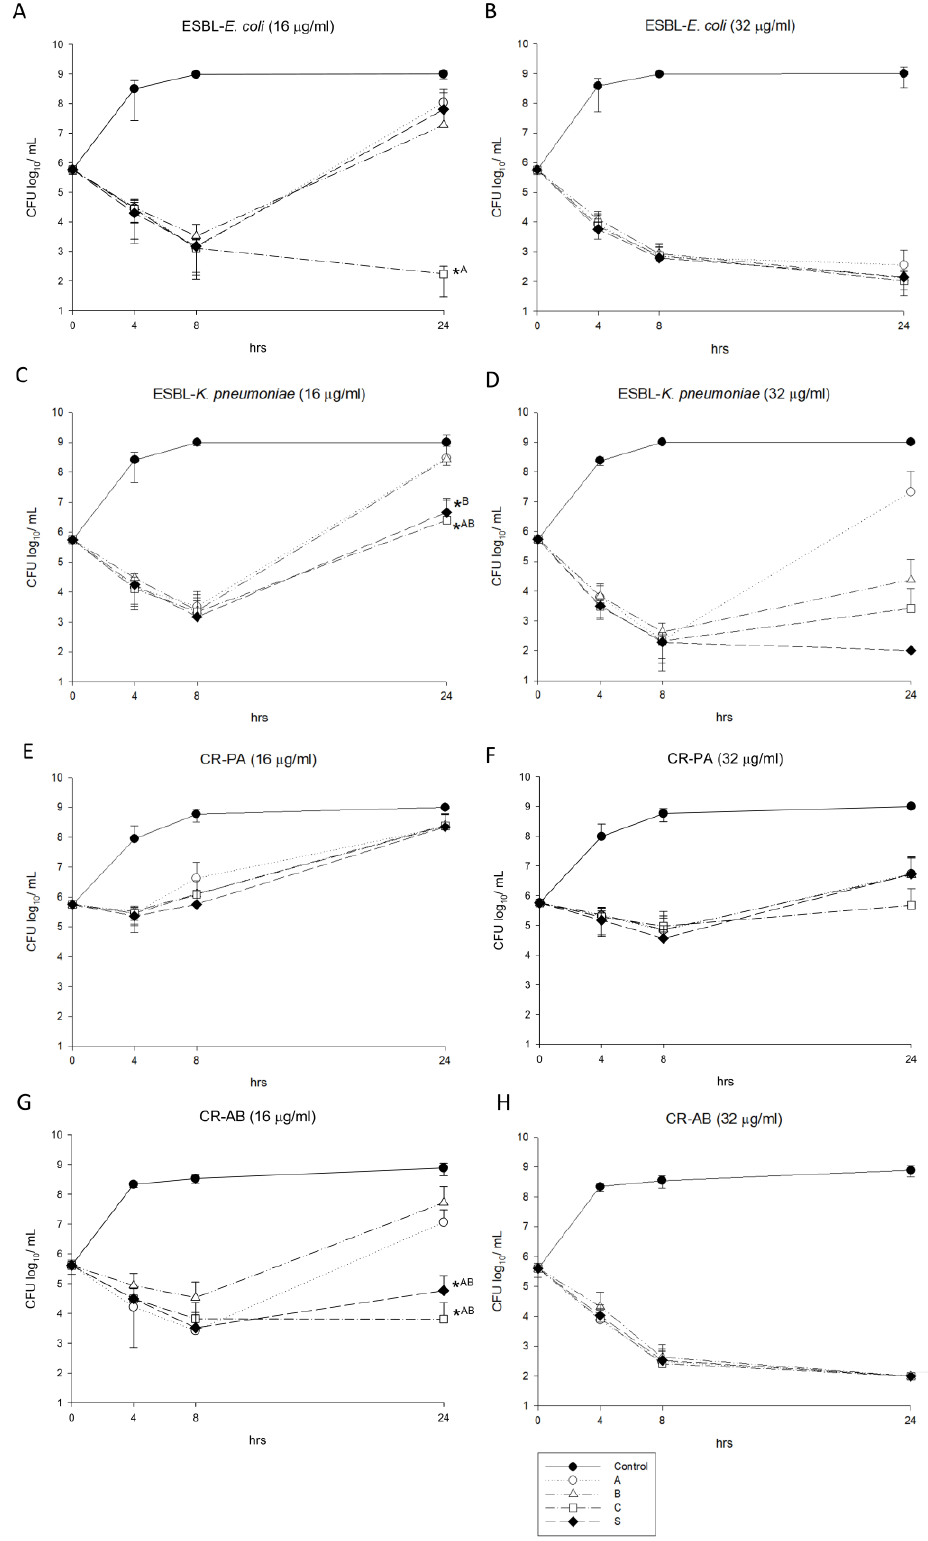
Figure 2. Time-killing study of di ff erent cefoperazone / sulbactam products against extended-spectrum β -lactamase (ESBL)- E. coli ( A , B ), ESBL- K. pneumoniae ( C , D ), carbapenem-resistant P. aeruginosa ( E , F ) and carbapenem-resistant A. baumannii ( G , H ) at the concentrations 16 / 16 µ g / mL and 32 / 32 µ g / mL (* p value < 0.05).